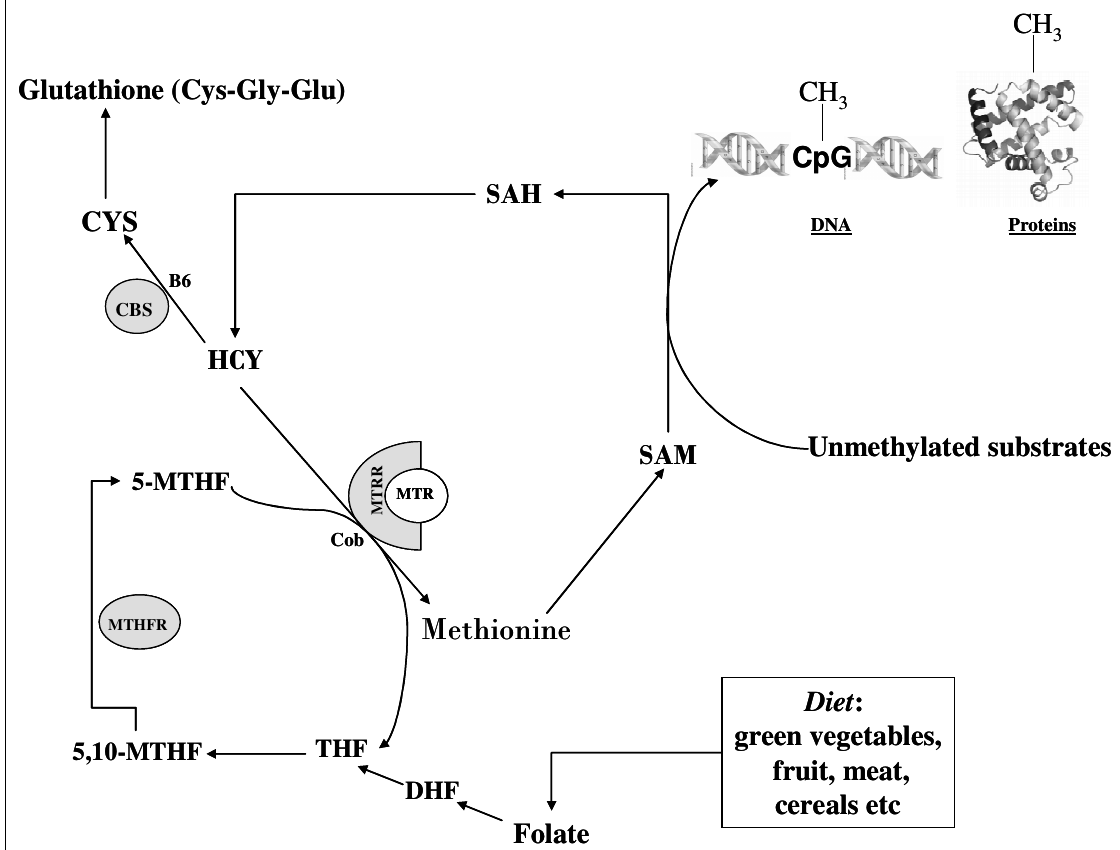
FIGURE 1 . Folate metabolic pathway. B6, vitamin B6; CBS, cystathionine- β -synthase; Cob, vitamin B12; CYS, cysteine; DHF, dihydrofolate; Glu, glutamic acid; Gly, glycine; HCY, homocysteine; 5-MTHF, 5-methyltetrahydrofolate; 5,10-MTHF, 5,10- methyltetrahydrofolate; MTHFR, methylenetetrahydrofolate reductase; MTR, methionine syntase; MTRR, methionine syntase reductase; SAH, S-adenosylhomocysteine; SAM, S-adenosylmethionine; THF,